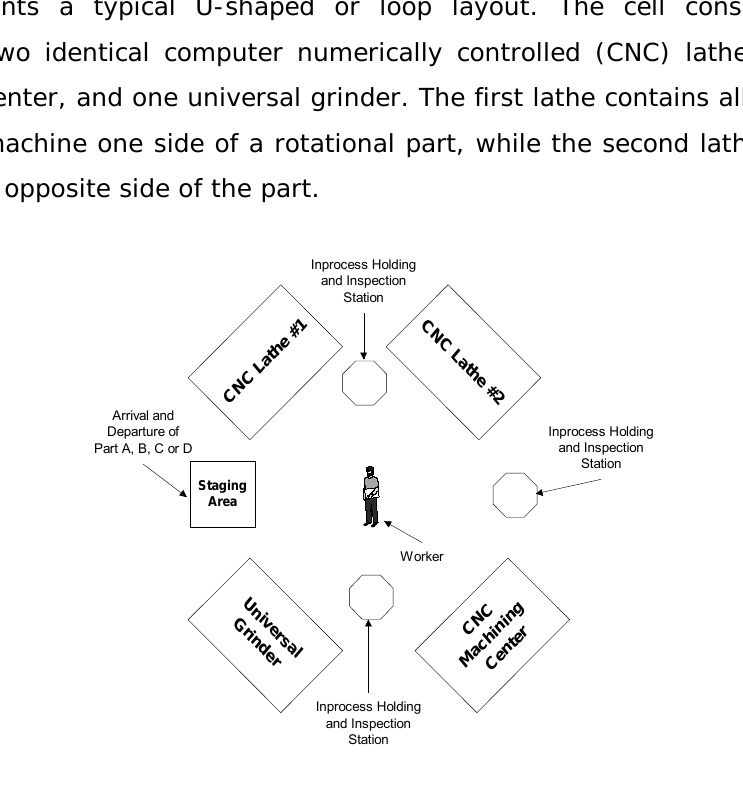
Figure 1. “U-shaped cell